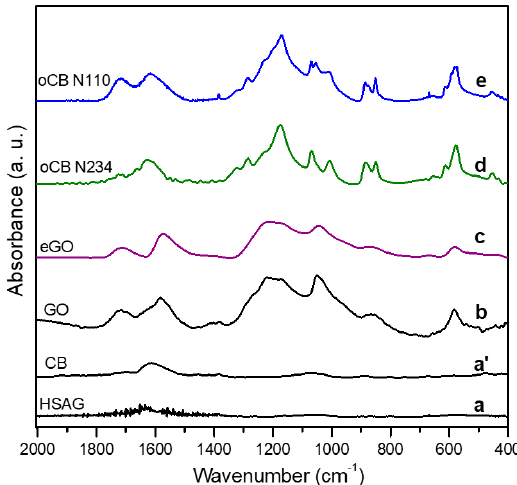
Figure 3. FTIR spectra, in the wavenumber range 2000–400 cm − 1 , of the high-surface-area graphite (HSAG) ( a ), of the derived GO ( b ) and eGO ( c ), and of the oxidized carbon black samples, oCB N234 ( d ) and oCB N110 ( e